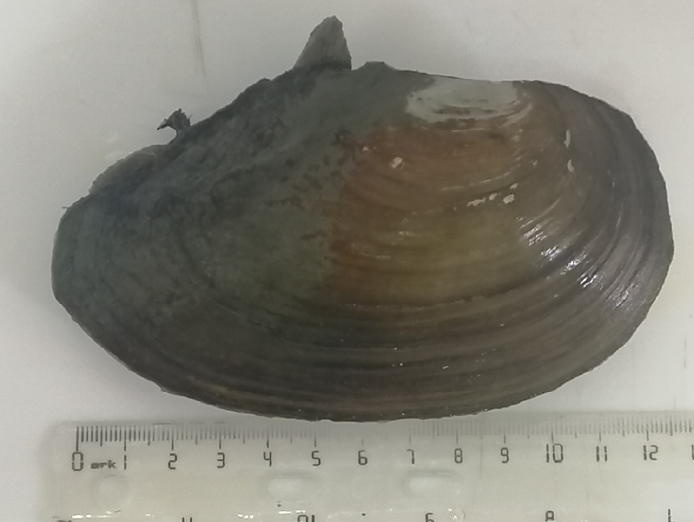
Figure 2. Anodonta cygnea from Macedonian part of Lake Prespa — original photo.